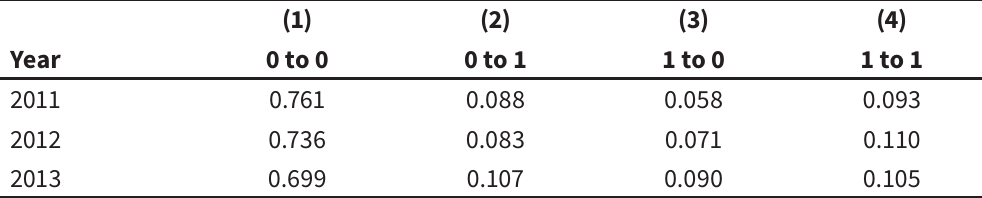
Patterns of migration